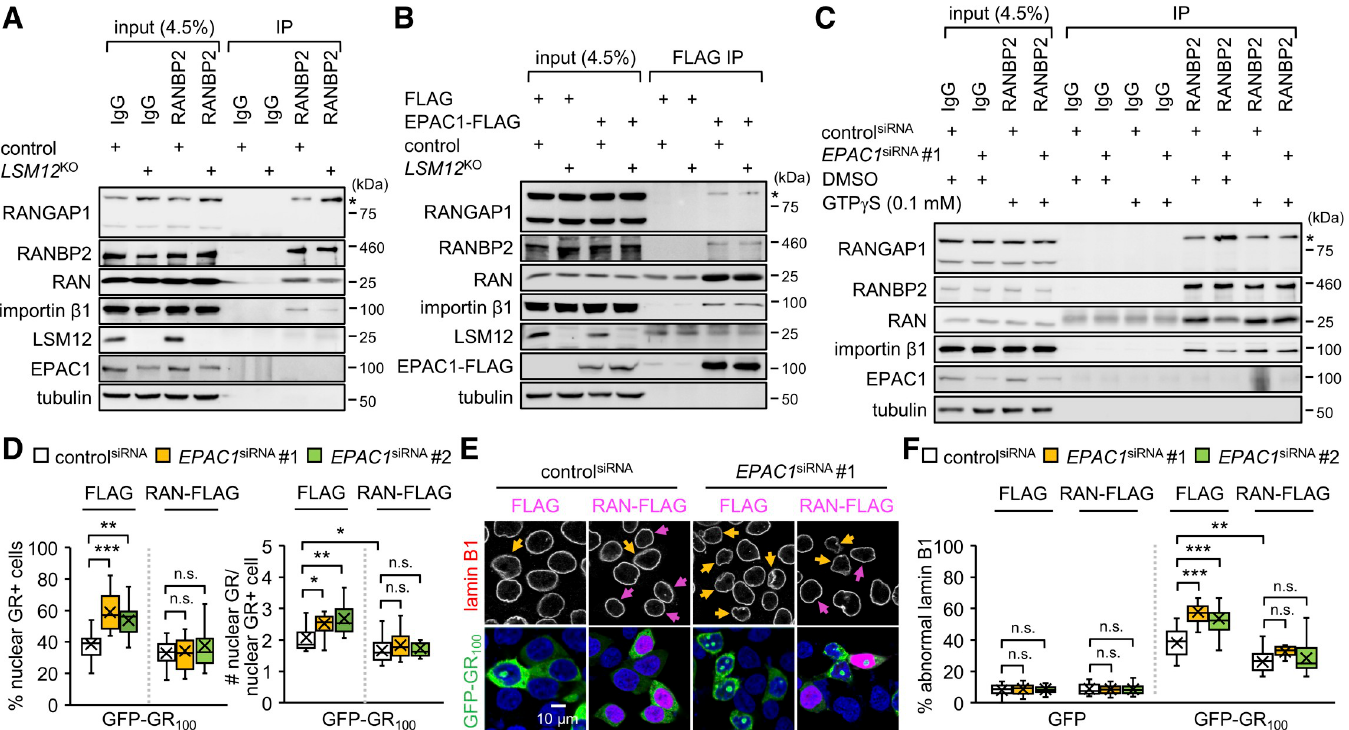
Fig 8. EPAC1 depletion limits RAN-GTP availability for assembly of the RAN-associating nuclear pore complex and suppression of poly(GR) toxicity. (A) LSM12 deletion dissociates RAN and importin β 1 from the RANBP2-RANGAP1 complex. Soluble extracts from control and LSM12 KO cells were immunoprecipitated with control IgG or anti-RANBP2 antibody. Purified IP complexes were resolved by SDS-PAGE and immunoblotted with specific antibodies (left). Asterisks indicate SUMOylated RANGAP1. Input, 4.5% of soluble extracts used in each IP. (B) EPAC1 overexpression restores the assembly of RAN-associating nuclear pore complex in LSM12 -deleted cells. Control and LSM12 KO cells were transfected with FLAG or EPAC1-FLAG expression vector. Soluble extracts were prepared 48 hours after transfection and then immunoprecipitated with anti-FLAG antibody. (C) The hydrolysis-resistant GTP analog, GTP γ S, blocks the dissociation of RAN and importin β 1 from the RANBP2-RANGAP1 complex in EPAC1 -depleted cells. Where indicated, soluble cell extracts were preincubated with 0.1 mM GTP γ S or DMSO (vehicle control) at 25˚C for 30 minutes before IP. (D) RAN overexpression suppresses the nuclear assembly of poly(GR) granules. SH-SY5Y cells were co-transfected with siRNA, GFP-GR 100 , and RAN-FLAG expression vectors, as in Fig 6A. Transfected cells were co-stained with anti-lamin B1 antibody (red), anti-FLAG antibody (magenta), and Hoechst 33258 (blue) 48 hours after plasmid DNA transfection. The assembly of nuclear poly(GR) granules was quantified similarly as in Fig 1. Data represent means ± SEM ( n = 15–17 confocal images obtained from 3 independent experiments; n = 280–471 GFP-GR 100 –positive cells). n.s., not significant; � P < 0.05, �� P < 0.01, ��� P < 0.001, as determined by 2-way ANOVA with Tukey post hoc test. (E, F) RAN overexpression suppresses the poly(GR)-induced disruption of the nuclear lamina. Yellow arrows indicate GFP-GR 100 –positive cells with severe nuclear lamina disruption. Magenta arrows indicate cells overexpressing RAN-FLAG protein. The abnormal morphology of the nuclear lamina was quantified as in Fig 3E. Data represent means ± SEM ( n = 16–17 confocal images obtained from 3 independent experiments; n = 325–547 GFP–or GFP-GR 100 –positive cells). n.s., not significant; �� P < 0.01, ��� P < 0.001, as determined by 2-way ANOVA with Tukey post hoc test. All underlying numerical values are available in S1 Data. ANOVA, analysis of variance; EPAC1, exchange protein directly activated by cyclic AMP 1; GFP, green fluorescent protein; IP, immunoprecipitation; LSM12, like-Sm protein 12; SEM, standard error of the mean; siRNA, small interfering